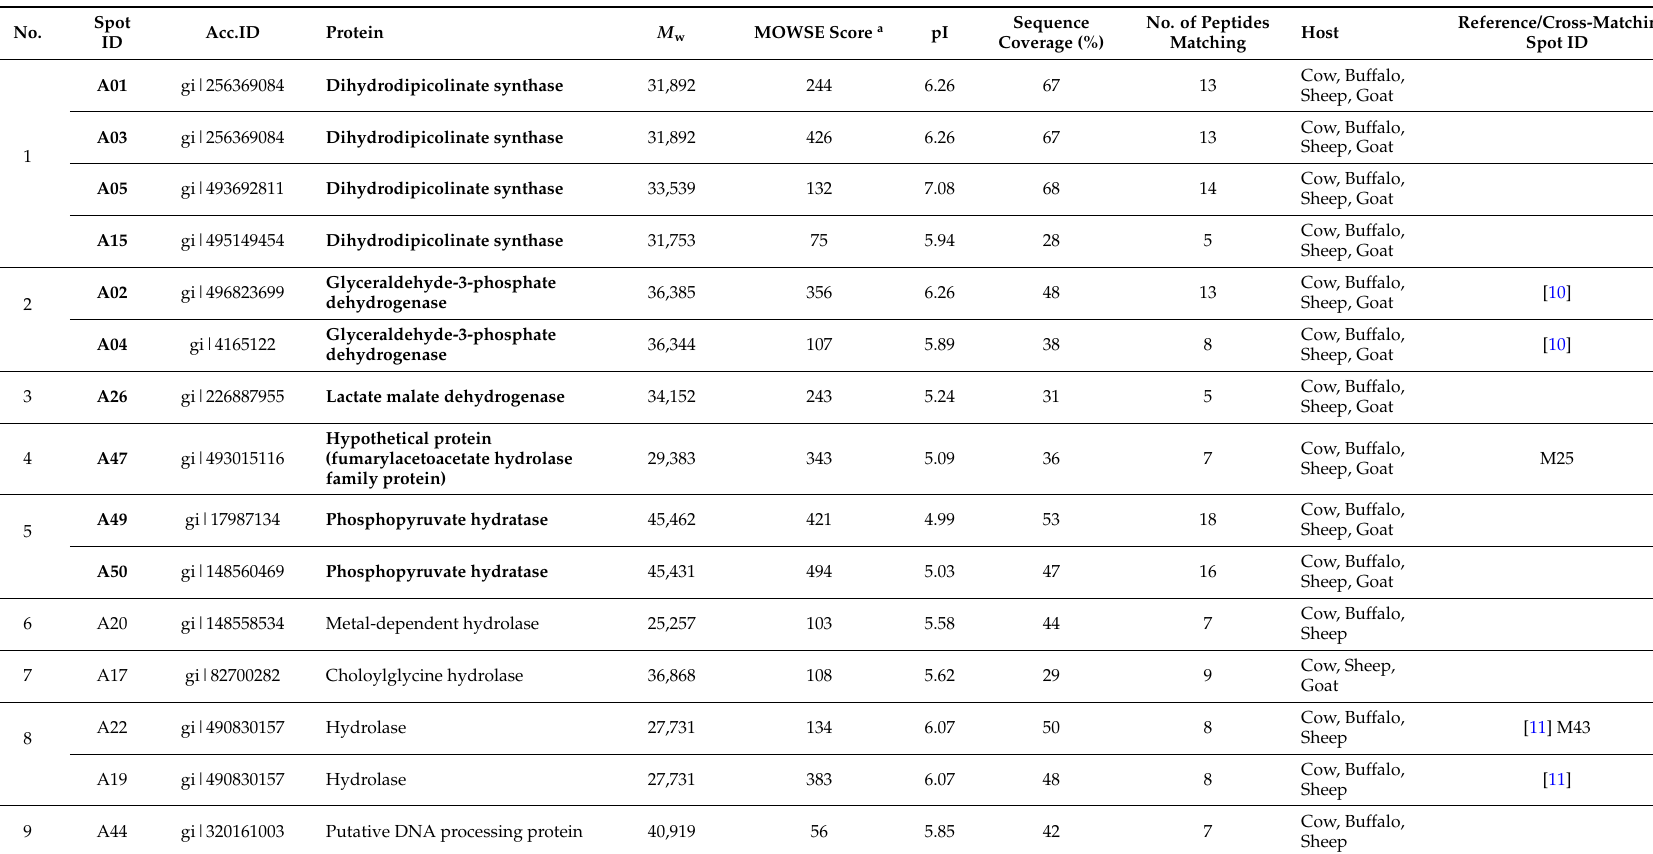
Table 1. Immunoreactive proteins from Brucella ( B. ) abortus using two dimensional electrophoresis Western blot and Matrix-assisted laser desorption/ionization-Tine of Flight-Mass Spectrometry (MALDI-TOF-MS). Spot ID: Spot identification; A: B. abortus ; M: B. melitensis ; Acc.ID: Accession number at the National Center for Biotechnology Information (NCBI) databank; Proteins: Description as in the NCBI database and the bold highlighted proteins were those considered as a promising candidate for future sero-diagnostics assays; M w : Molecular weight; MOlecular Weight Search (MOWSE) score: ´ 10*Log ( p ), where p is the probability that the observed match is a random event. This list includes only bands with a MOWSE score greater than ( p <0.05); pI: Isoelectric point; Sequence coverage (%): Is the percentage of peptide that covers the complete sequence of the protein; No. of peptides matching: Is the number of peptides that matched with the protein sequence.